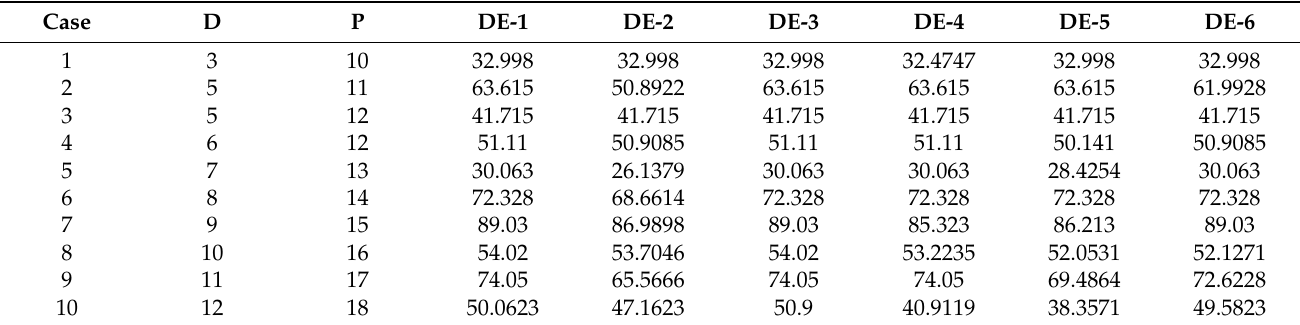
Table 13. Fitness function values for six discrete DE algorithms with population size NP = 30; r D = r P =